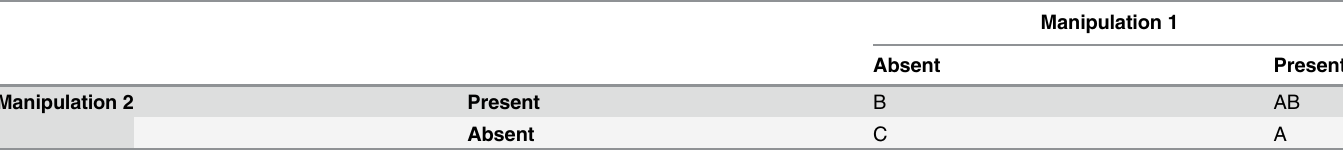
Table 1. The 2x2 experimental design for combining two